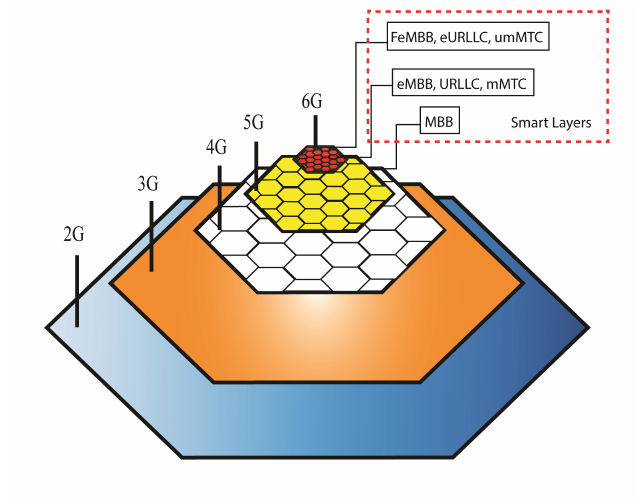
Figure 16. Network